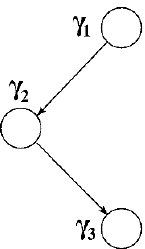
Figure 13. A BPS quiver for the ( A 1 ; D 3 ) Argyres-Douglas